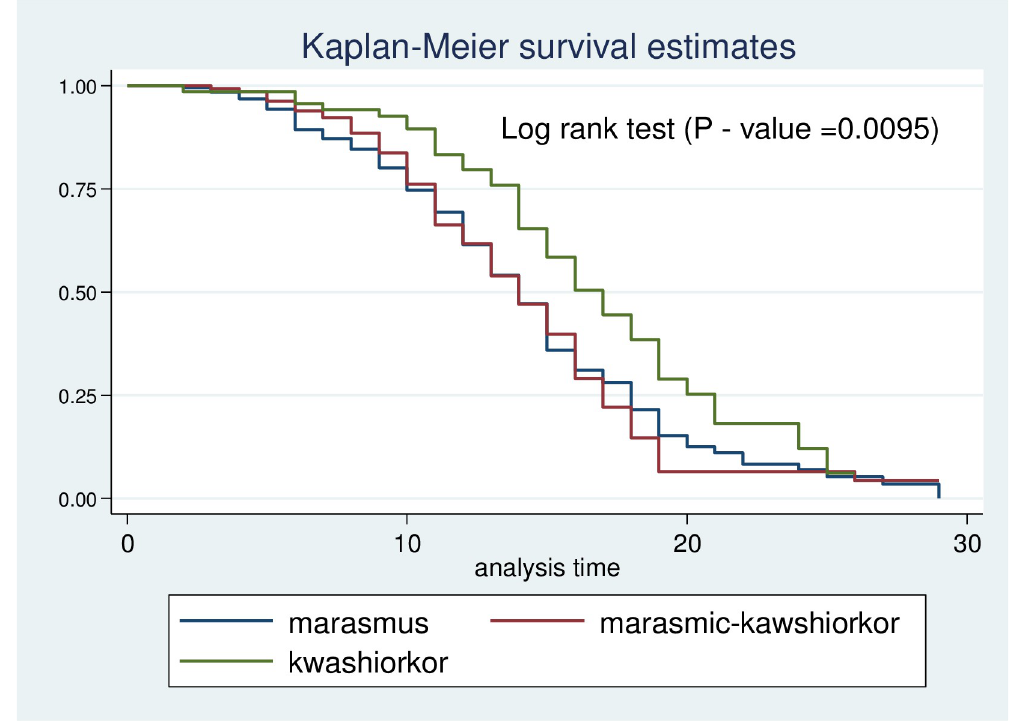
Fig 6. Log-rank survival estimate for time to recovery of SAM children by types of malnutrition.